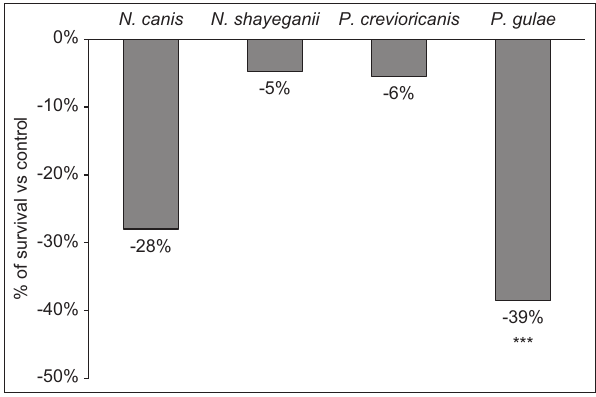
Figure-1: Survival of cells in biofilms after exposure to the pomegranate extract. The data are expressed as the percentage of survival for each strain, based on the reduction in mean optical density (OD) values in the treated biofilms versus control. ***p < 0.001: Statistically significant difference in OD values versus control (student’s